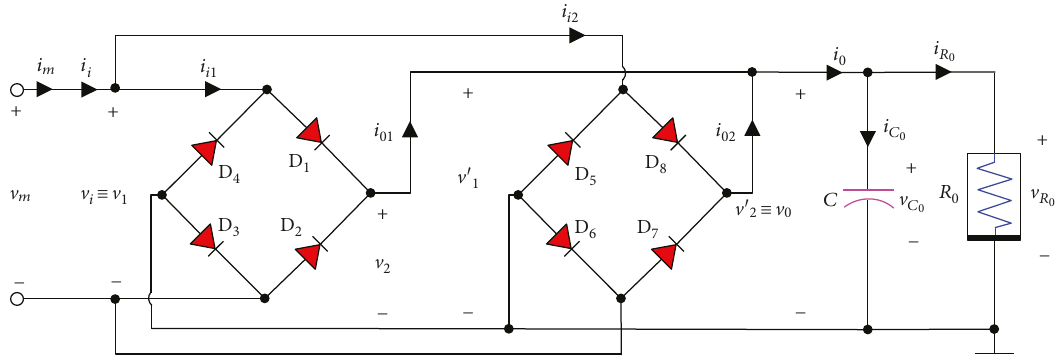
Figure 10: Circuit diagram of the real 6-lobe Chua corsage memristor emulator with quad-stable input